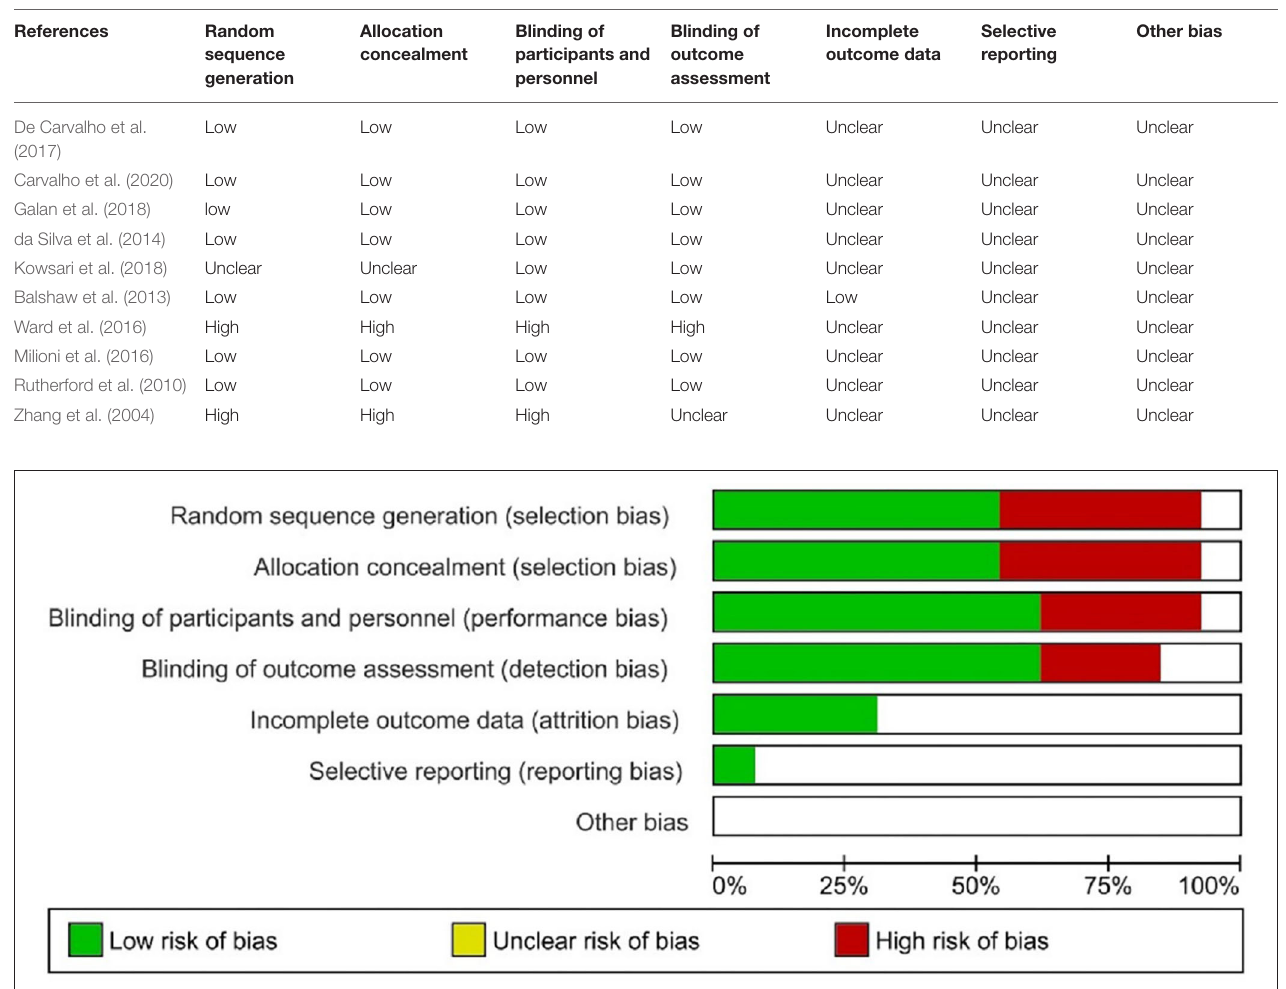
TABLE 3 | Risk of bias evaluation of included studies.